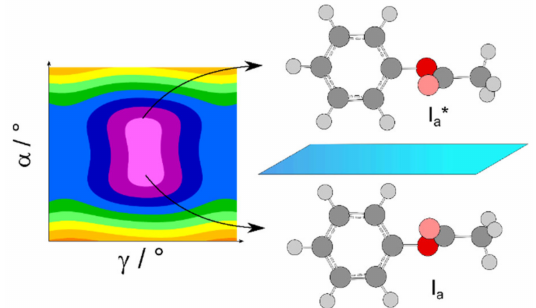
Figure 20. The coupled large amplitude motions of phenyl acetate. Left hand side: 1/6 of the potential energy surface calculated at the MP2/6-311++G(d,p) level of theory demonstrating the methyl and the phenyl torsions ( α and γ , respectively). Right hand side: Two equivalent minima of phenyl acetate, reflecting the equilibrium configuration I a and its mirror image I a *. The inversion-tunneling motion connects these two minima.